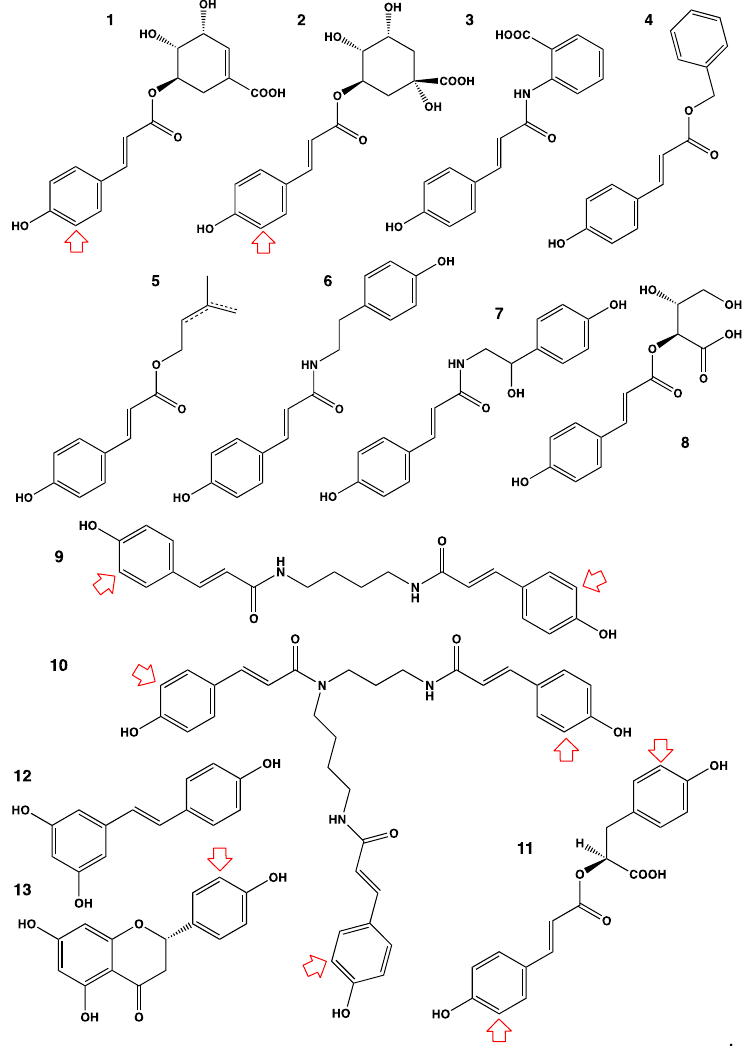
Figure 6. A representative sample of the confirmed substrates of CYP98 enzymes. Red arrow indicates the site of oxidative attack when determined. p -Coumaroyl-shikimate currently appears as the preferred substrate for CYP98s in Spermatophytes. p -Coumaroyl-anthranilate is the preferred substrate of CYP98s from Bryophytes and Lycophytes in vitro [49], yet p -coumaroyl-shikimate seems to be the most relevant substrate in vivo in moss [44]. Different enzymes (plant source or paralog) have different substrate preferences and all metabolize a range of conjugates with various efficien- cies. Relaxation of substrate specificity and/or specialization occurs in some taxa, usually after gene duplication. Similar specialization can occur repeatedly with slightly different issues (e.g., [52]). In the vast majority of cases p -coumaroyl-shikimate activity is maintained in the specialized duplicates, at low to high levels. All substrates shown here have physiological relevance in planta as precursor of lignin, UV screen or defense compounds. 1 : 5- O -( p -coumaroyl)-shikimate (lignin precursor; high- est turnover reported for an NADPH-dependent plant P450 enzyme); 2 : 5- O -( p -coumaroyl)-D-qui- nate (precursor of chlorogenic acid); 3 : p -coumaroyl-anthranilate; 4 : benzyl- p -coumarate; 5 : prenyl- or isoprenyl- p -coumarate; 6 : p -coumaroyl-tyramine; 7 : p -coumaroyl-octopamine; 8 : p -coumaroyl-4- threonate; 9 : N,N’ -di- p -coumaroyl-putrescine (hydroxylated on both phenolic rings); 10 : N , N ’, N ”- tri- p -coumaroyl-spermidine (hydroxylated on the three phenolic rings); 11 : 2- O -(4-coumaroyl)- 3 -(4- hydroxyphenyl)lactic acid (precursor of rosmarinic acid; hydroxylated on both phenolic rings); 12 : trans -resveratrol; 13 : naringenin.